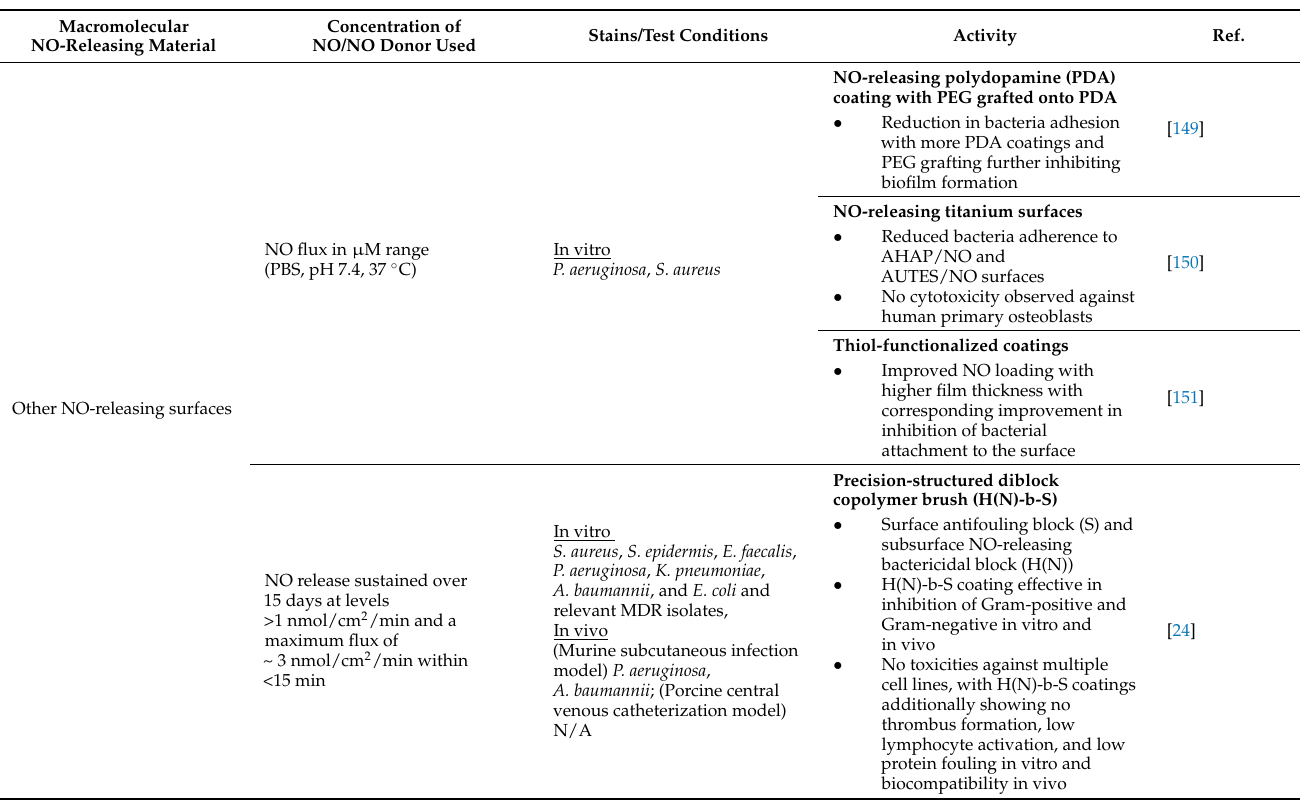
Table 4. Comparison of advantages and disadvantages of each NO-donor and